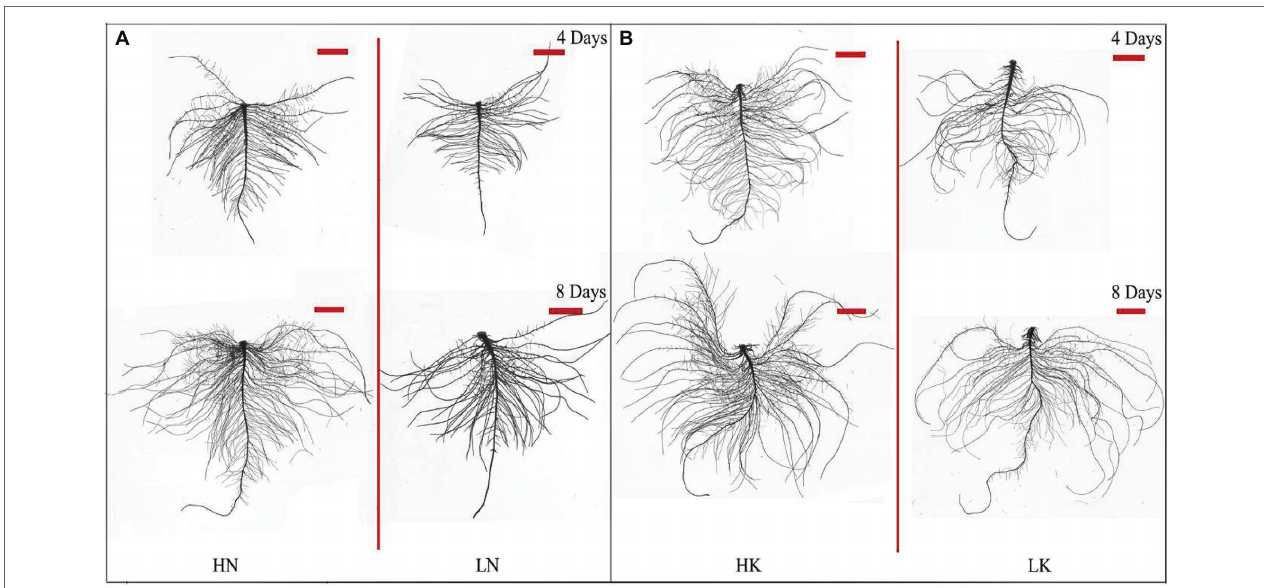
FIGURE 2 | Root morphology difference between high N (HN) group and low N (LN) group (A) and the difference between high K (HK) group and low K (LK) group (B) after 4 and 8 days of treatments. N, nitrogen and K, potassium. The original size of the target bar is 0.2 cm high and 3.5 cm